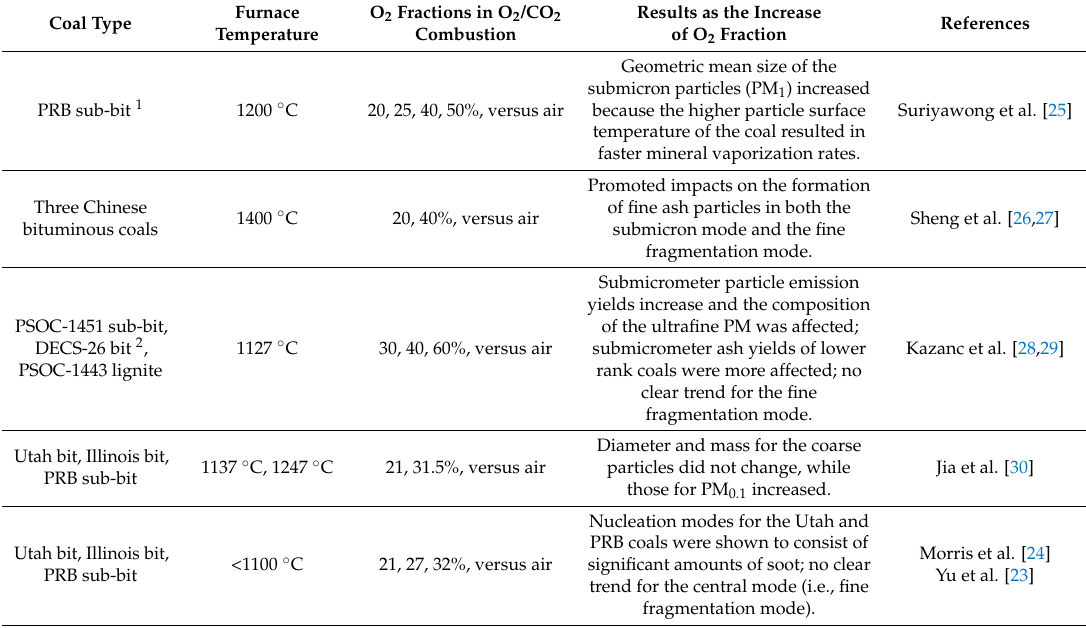
Table 1. Studies on the effect of O 2 fraction on the emission behaviors of particulate matter (PM) during oxy-fuel coal